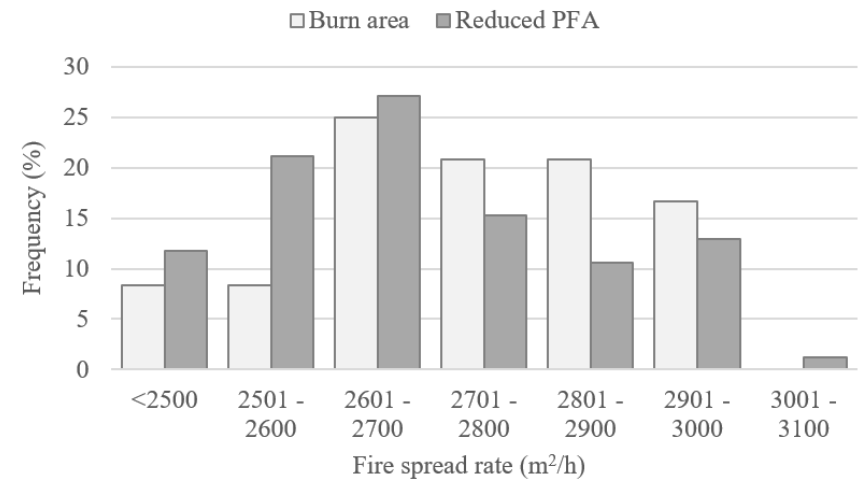
Figure 18. Histogram showing the predicted fire spread rates for the reduced PFAs and burn areas mapped from satellite images.